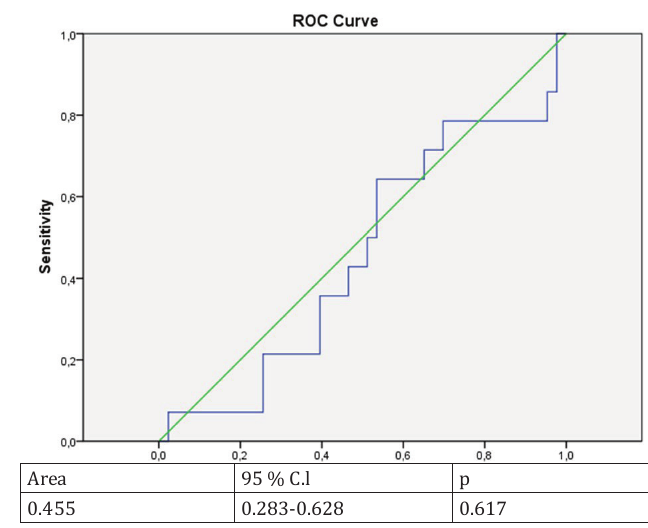
Figure 1 - PCT predictive probability of the malignancy Figure 2 - PCT predictive probability of